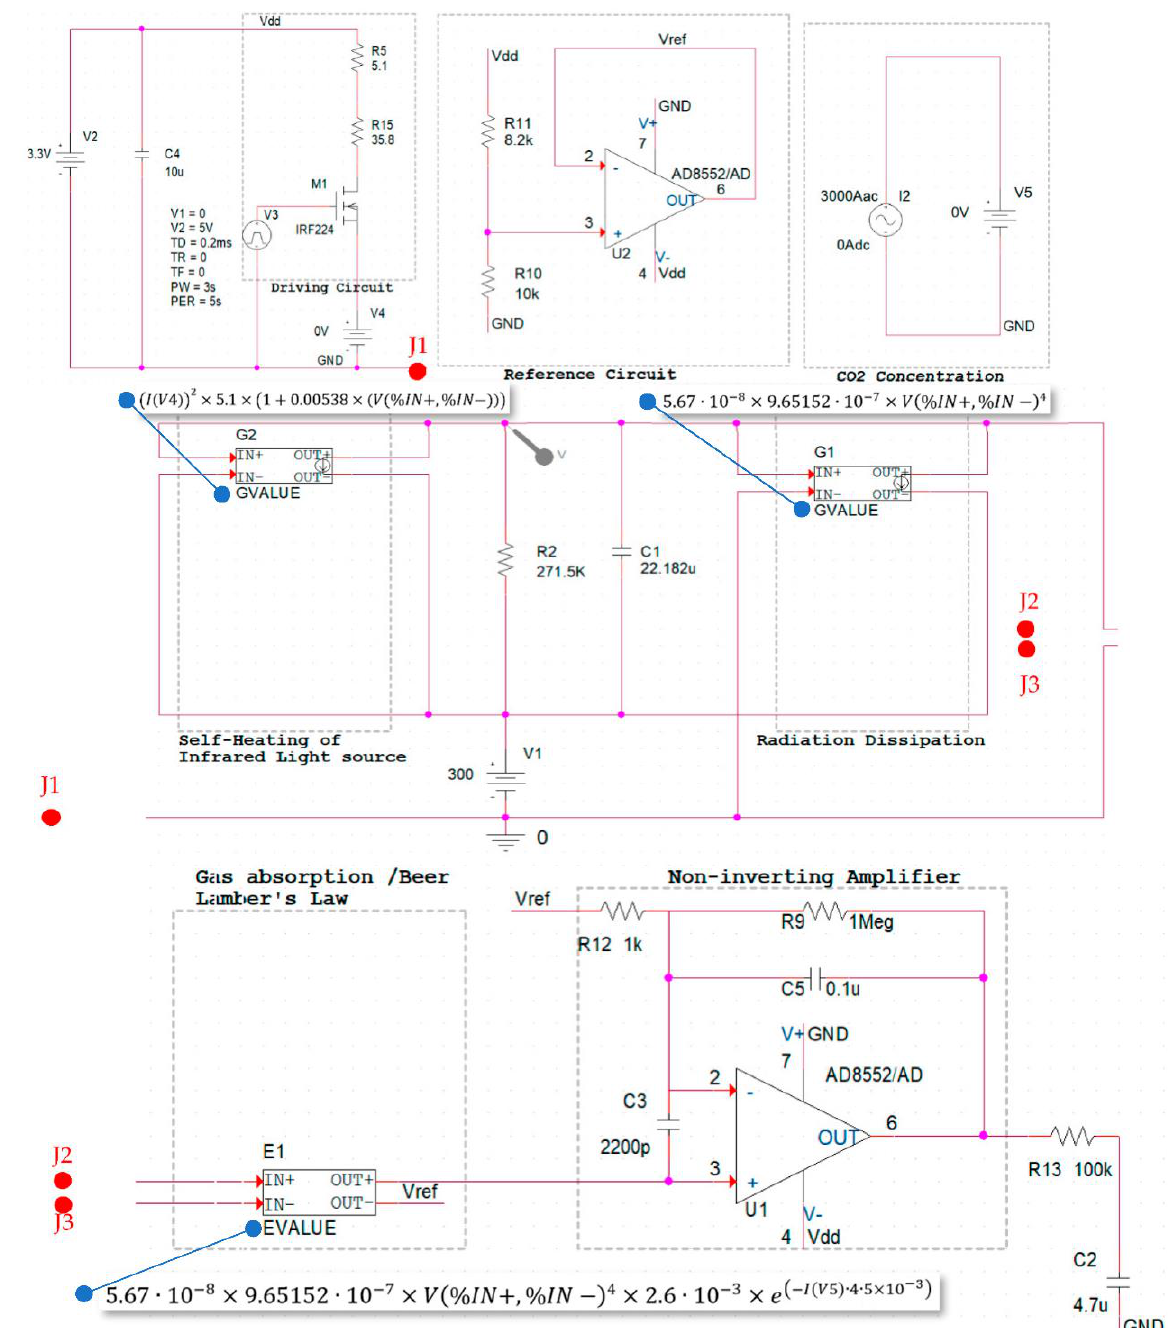
Figure 5. Driving circuit of IR light source.